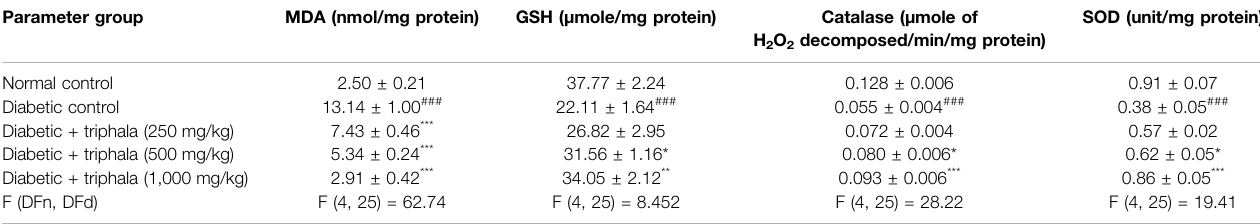
TABLE 1 | Effect of Triphala churna on oxidative stress parameters. Parameter group